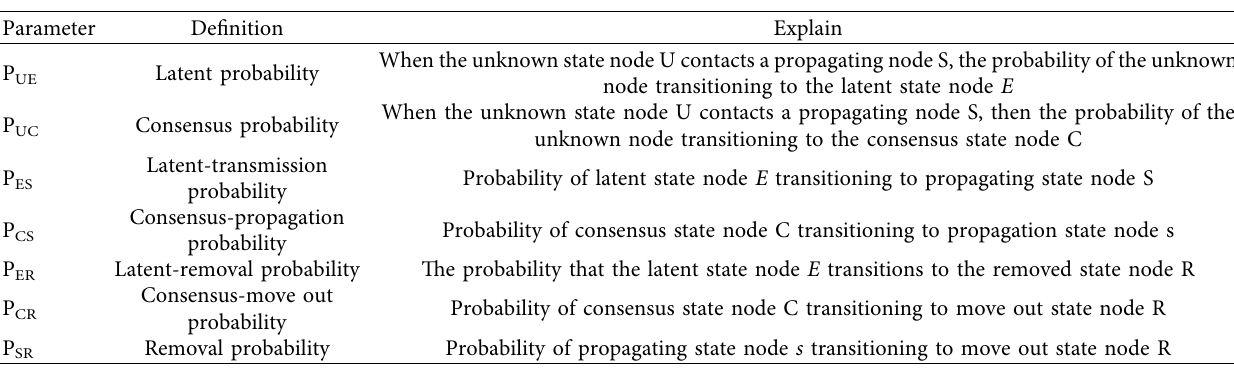
Table 4: The UECSR model parameter